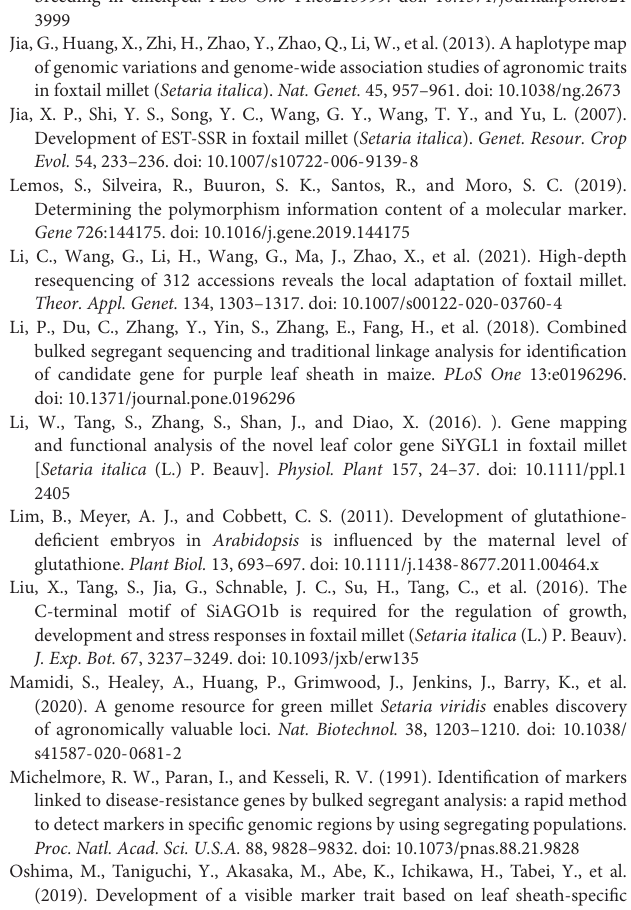
Supplementary Figure 1 | Introduction to positional cloning in foxtail millet using “SSR41”. (A) A general view of positional cloning in foxtail millet. (B) Introduction of linked and unlinked markers used in PCR tests. (C) A summary of bulked segregant analysis (BSA) for primary mapping of SiWLS1 . (D) DNA agarose gel electrophoresis results for primary mapping. Supplementary Figure 2 | General statistics of “SSR41” resequencing data. (A) Genome-wide distribution of read coverage. (B) Statistics of read coverage and sequencing depth. (C) Single nucleotide polymorphism (SNP) depth and neighboring SNP distance distributions. Supplementary Figure 3 | Annotations of SNPs between “SSR41” and “Yugu1”. Supplementary Figure 4 | Comparisons of plant growth between “Yugu1” and siwls1 in response to arsenic treatment. Significant differences were determined by Student’s t -test (ns = no significant difference, ∗ p < 0.01, ∗∗ p < 0.001). Supplementary Figure 5 | Comparisons of plant growth between “Yugu1” and siwls1 in response to cadmium treatment. Significant differences were determined by Student’s t -test (ns = no significant difference, ∗ p < 0.01, ∗∗ p <